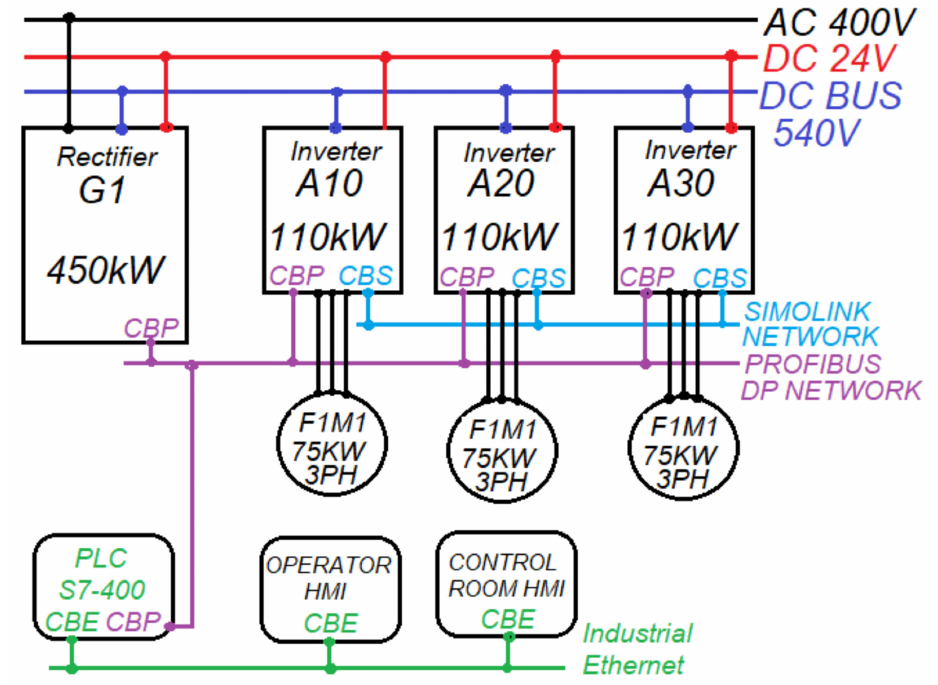
Figure 2. Part of the electrical control supply schema for the stacker machine